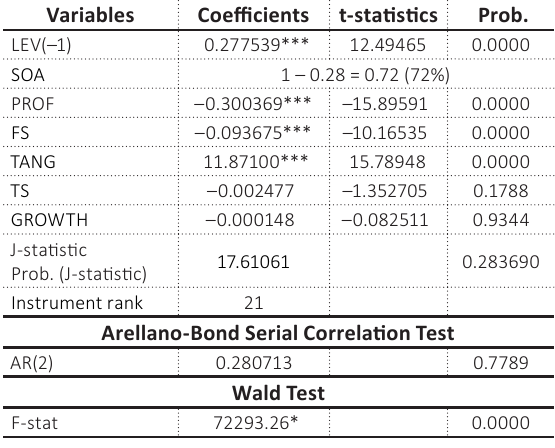
Table 2. System GMM